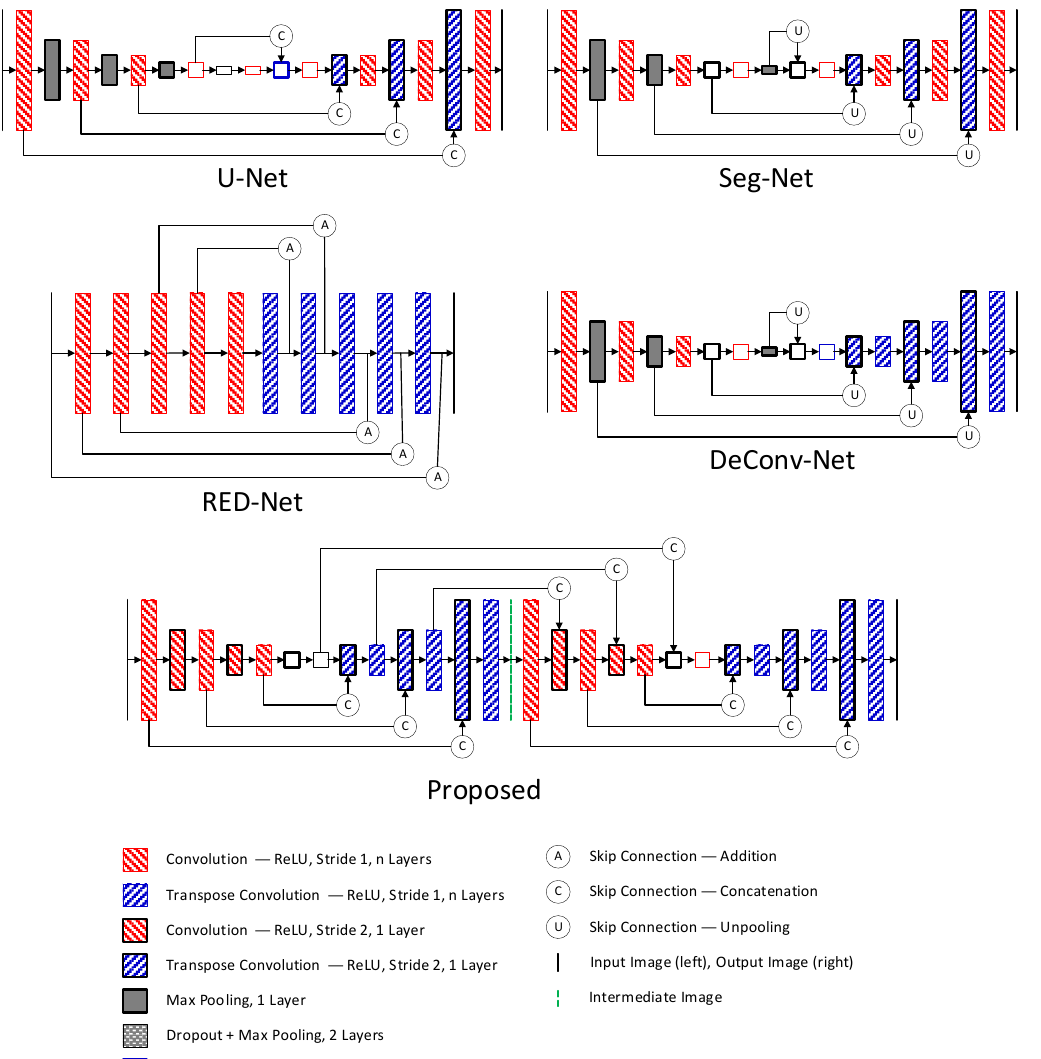
Figure 1. Comparison diagram between the model reference and the proposed model, including a slight modification to fit the denoising problem. The convolution and transpose convolution stride one blocks can have more than one layer ( n Layers) (i.e., single layer with 3 × 3 filter, dual layers with 3 × 3